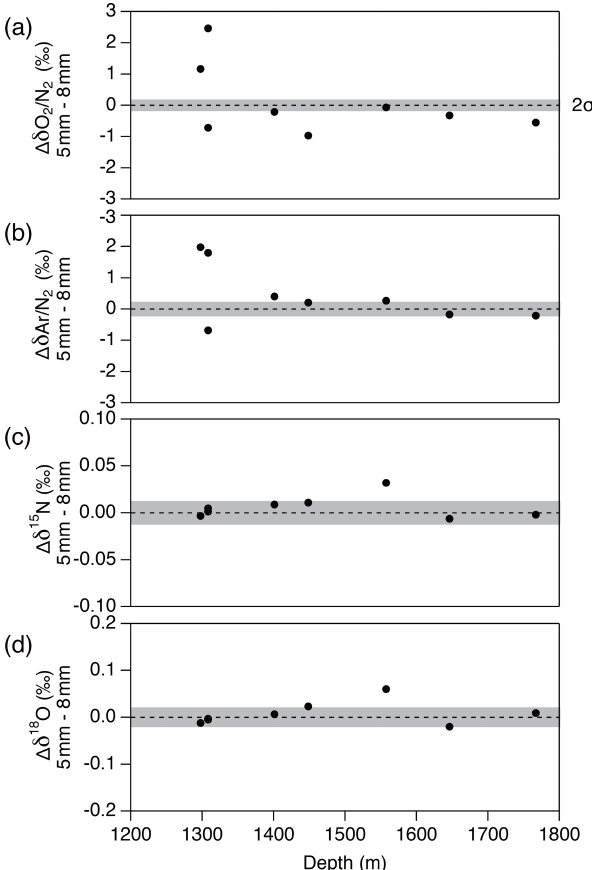
Figure 14. Pair difference between the two inner ice pieces with the thickness of outer removal of 5 and 8mm for (a) δ O 2 / N 2 , (b) δ Ar / N 2 , (c) δ 15 N and (d) δ 18 O. Grey shadings indicate the es- timated 2 σ uncertainty for clathrate ice (from pooled SDs of dupli- cates with > 8mm of outer